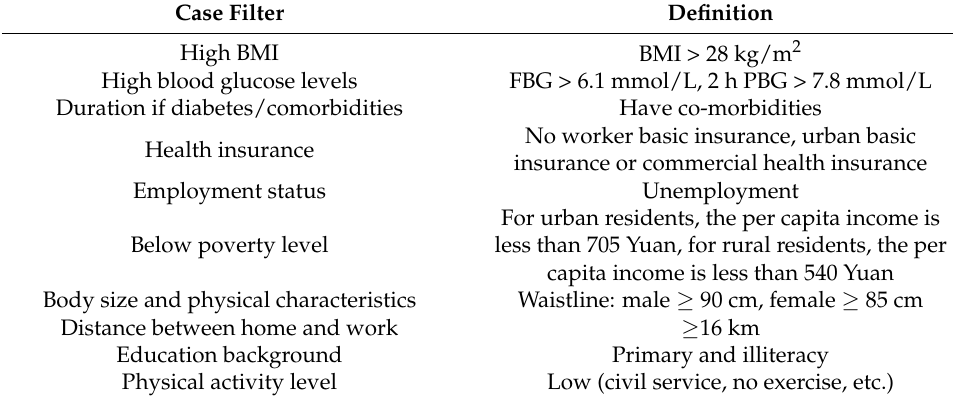
Table 1. Case filter and its